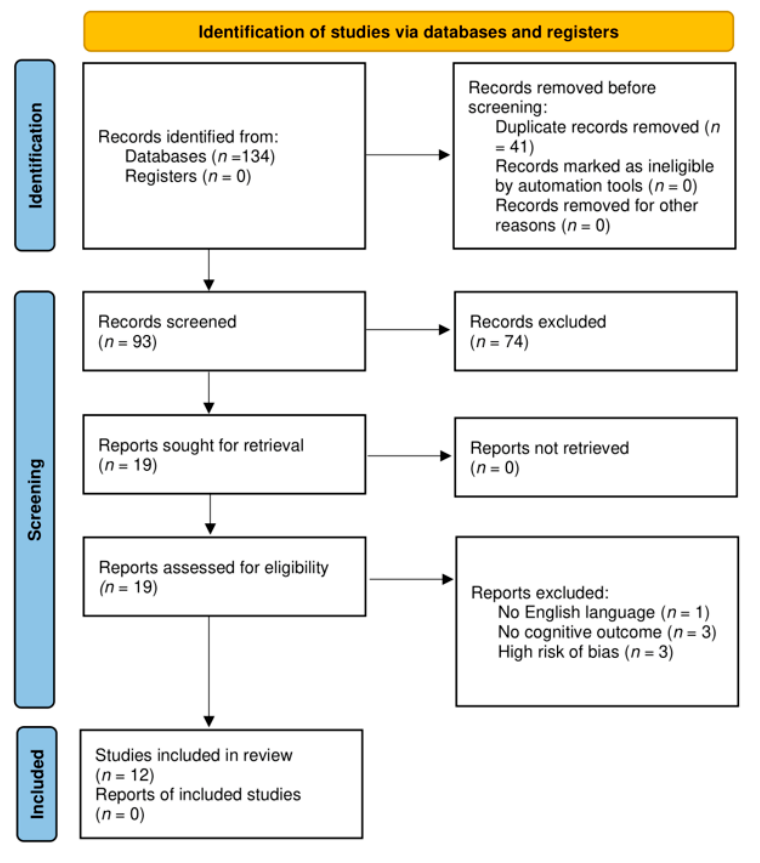
Figure 1. Flow-chart of the selected studies.